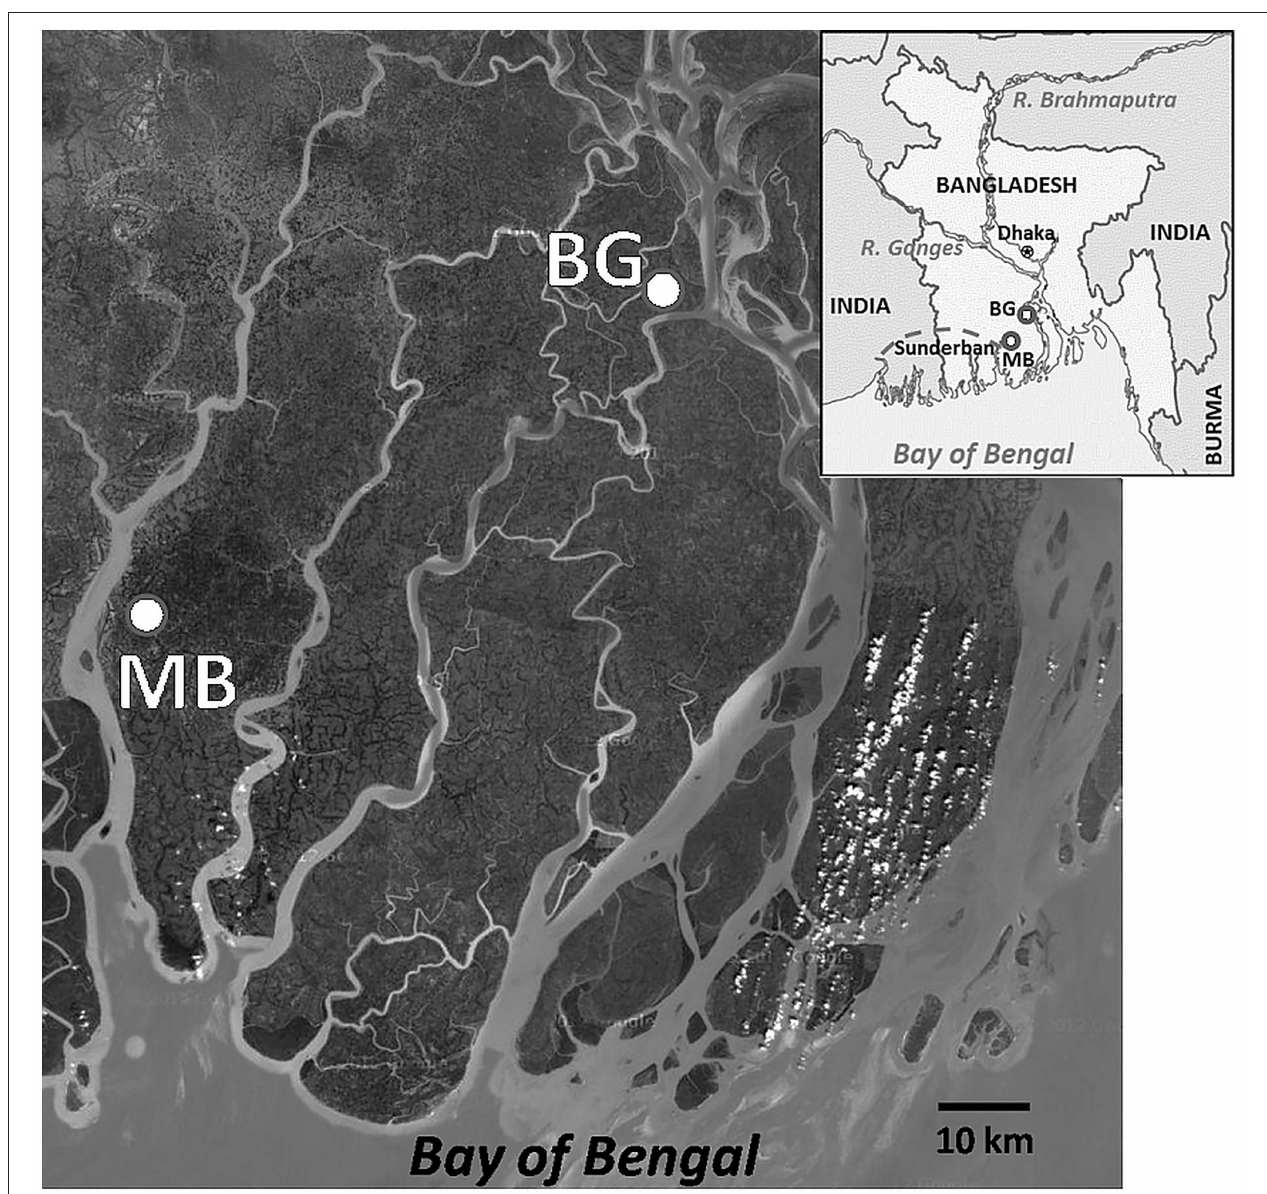
FIGURE 1 | A geographical view of the study areas in the coastal villages of the Bengal delta, Bangladesh. Location of study sites, Mathbaria (MB) and Bakergonj (BG), are shown by closed circles. Inset showing a map of Bangladesh, including areas where water samples were collected from the coastal zones of